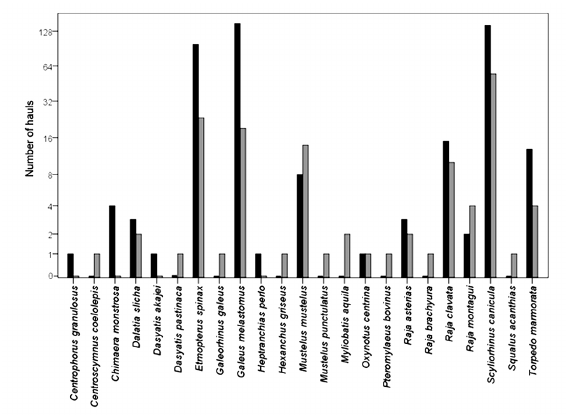
Fig. 4. – Abundance of hauls including each of the 23 species of car- tilaginous fish (log scale) from node-1 (black columns) and node-2 (grey columns) habitats groups (see text).